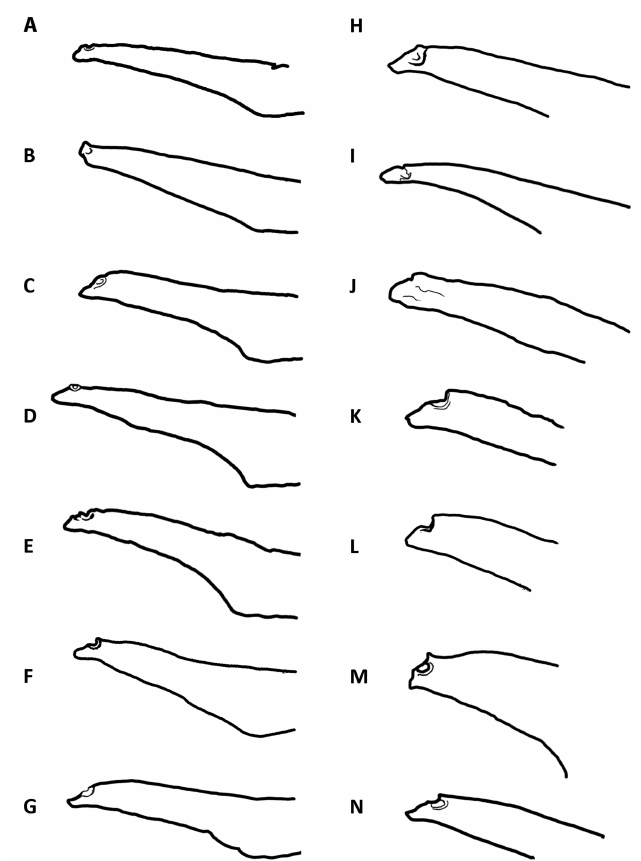
Figure 7. Comparisons of mandibles of Pteranodon sensu lato, in lateral view: A, UALVP 24238; B, KUVP 2212; C, YPM 1117; D, CMC VP 7203; E, FHSM VP 221; F, ANMH 7515, G; USNM 12167; H, FHSM 2183; I, KUVP 27828; J, FHSM VP 2148; K, KUVP 924; L, YPM 2525; M, YPM 1175; N, YPM 2487. A, from original photographs. B, D- H, J, and K after photographs in Everhart (2014). C, after photo in Eaton (1966). I, L, M, and N after illus- trations in Bennett (2001). Mandibles not to